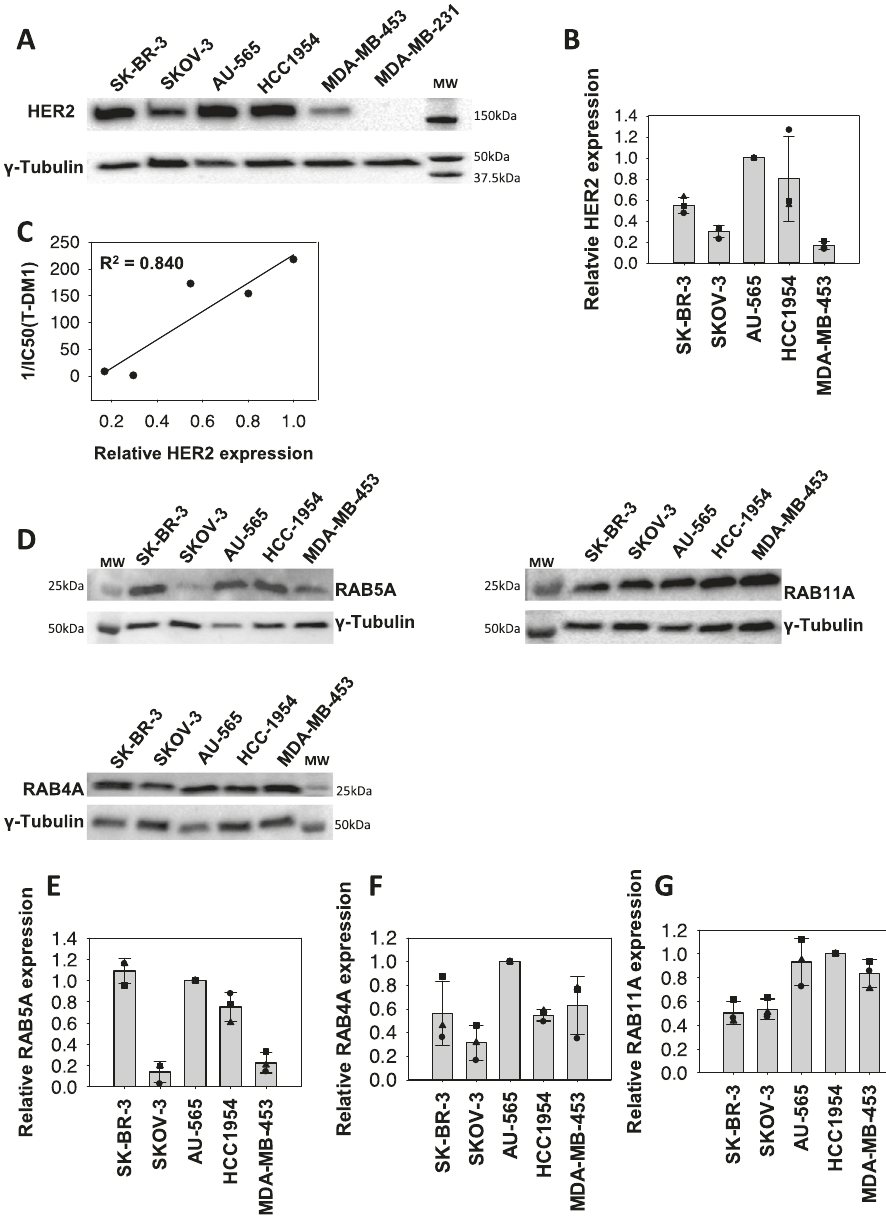
Fig. 2 HER2 and RAB GTPase expression in cell lines. A Representative Western blot of HER2 and γ -tubulin expression in SK-BR-3, SKOV-3, HCC1954, AU-565, MDA-MB-453, and MDA-MB-231 cells ( n = 3). B Quanti fi cation of the HER2 Western blots relative to those of γ -tubulin. Data points represent the values of three independent experiments, the bars represent the average and the error bars represent the SD of the mean. C Linear regression analysis curve of HER2 protein expression and T-DM1 sensitivity (1/IC 50 (T-DM1)). D Representative western blot ( n = 3) of RAB4A, RAB5A, RAB11A, and γ -tubulin expression in SK-BR-3, SKOV-3, AU-565, HCC1954, and MDA-MB-453 cells. E – G Quanti fi cation of the RAB4, RAB5, and RAB11 Western blots relative to those of γ -tubulin. Data points represent the values of three independent experiments, the bars represent the average and the error bars represent the SD of the mean. Source data are provided as a Source Data fi